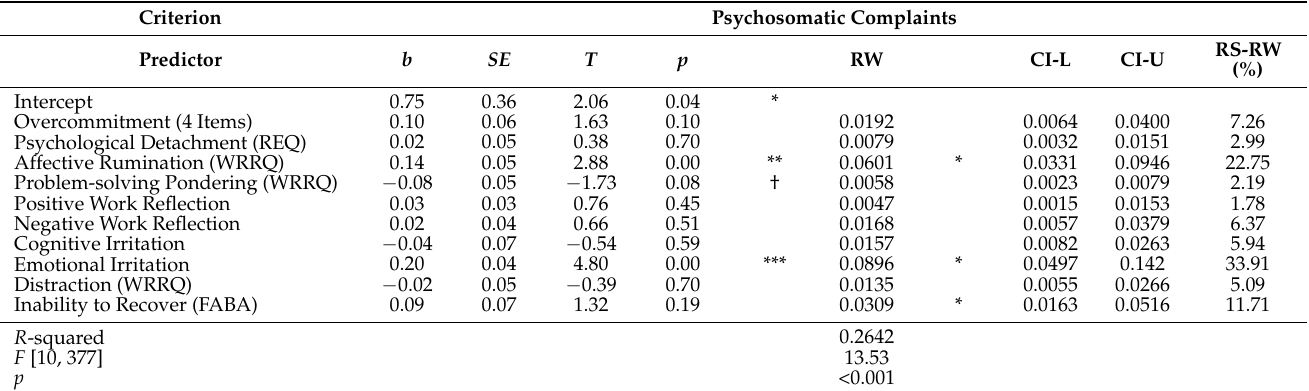
Table 12. Coefficients of the Relative Weight Analyses Predicting Psychosomatic Complaints (Sample 2).